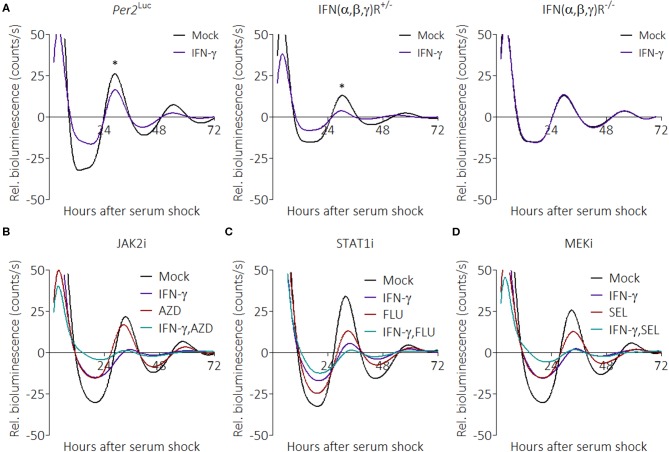
IFN-γ suppresses PER2 through its cognate receptor but does not act through canonical pathways. (A) Detrended PER2LUC traces from mPer2Luc, mPer2LucIFN(α/β,γ)R+/−, or mPer2LucIFN(α/β,γ)R−/− BMDMs treated with mock or IFN-γ (50 ng/mL for 24 h). (B) PER2LUC traces from mPer2Luc BMDMs treated with mock, IFN-γ, JAK2 inhibitor, or IFN-γ plus JAK2 inhibitor. (C) PER2LUC traces from mPer2Luc BMDMs treated with mock, IFN-γ, STAT1 inhibitor, or IFN-γ plus STAT1 inhibitor. (D) PER2LUC traces from mPer2Luc BMDMs treated with mock, IFN-γ, MEK inhibitor, or IFN-γ plus MEK inhibitor. Data are represented as mean (n = 3–4). P-values (*) are calculated from one-way ANOVA with post-hoc Tukey tests at the acrophase and are considered to be significantly different with P < 0.05.